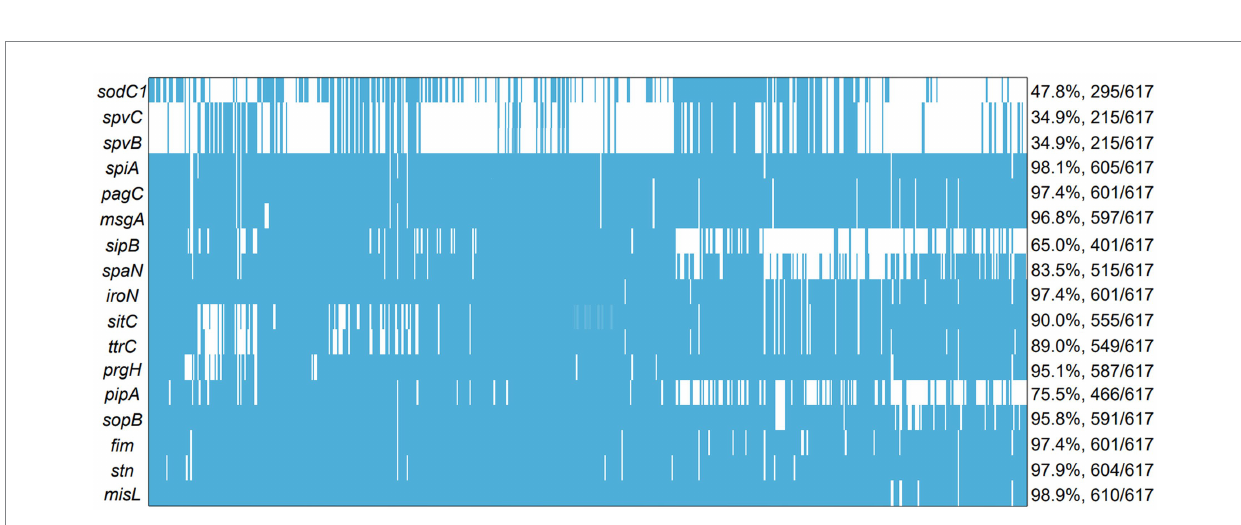
FIGURE 5 The analysis of virulence genes among 617 Salmonella islolates from food animals in China. The blue squares represent positivity for